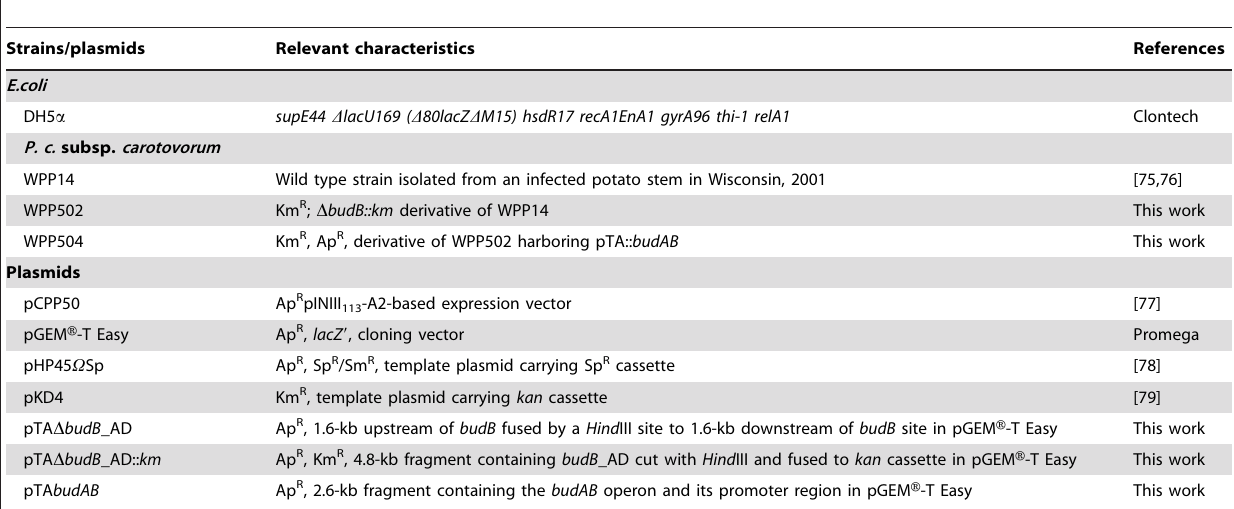
Table 1. Bacterial strains and plasmids used in this